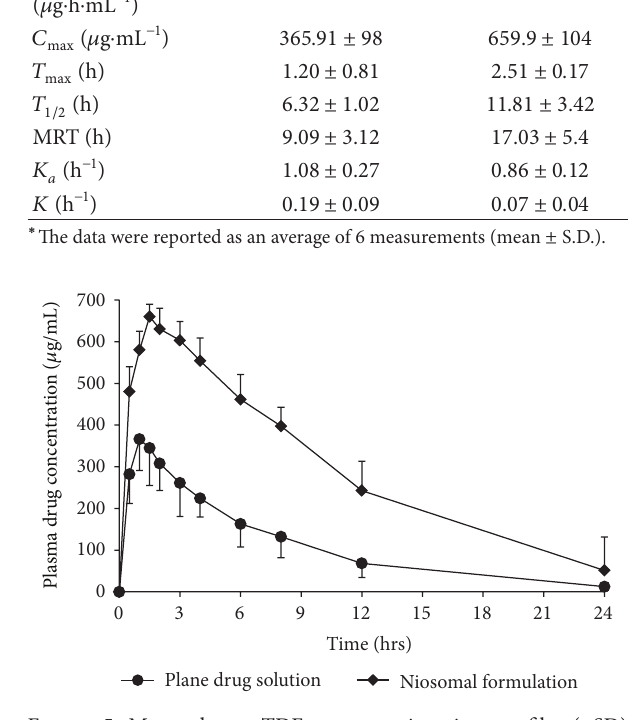
Figure 5: Mean plasma TDF concentration time profiles ( ± SD) in rats after oral administration of plane drug solution ( e ) and niosomal formulation ( Q ) as a single dose of 95 mg/kg (𝑛 = 6)